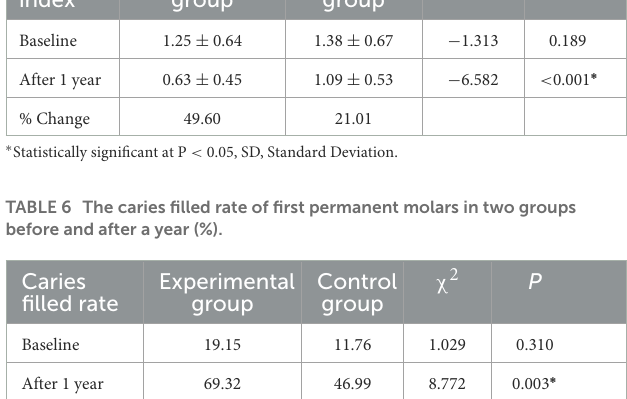
TABLE 5 Plaque index in two groups at baseline and after a year (mean ± SD). Plaque Experimental index group